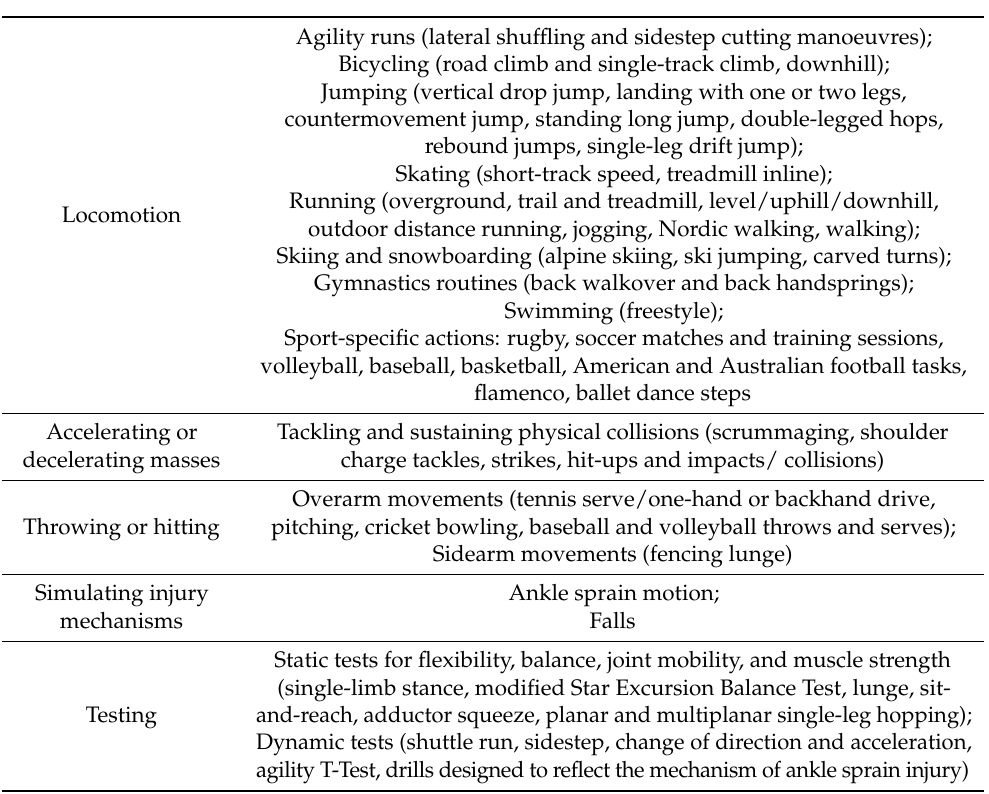
Table 1. Breakdown of motor tasks investigated, classified by different gross motor skills or aims of the motor